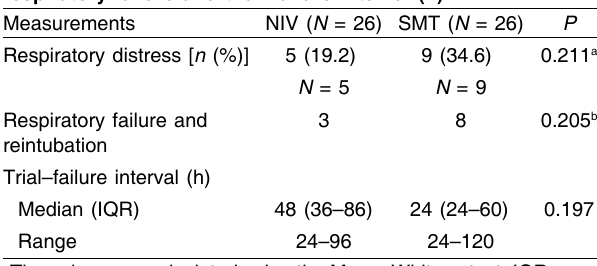
Table 5 Comparison between the study groups as regards respiratory failure and trial–failure interval (h) Measurements